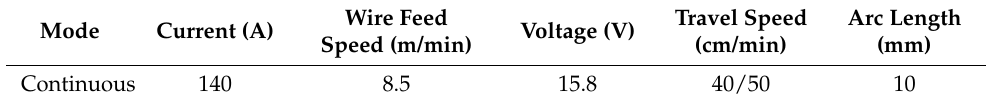
Figure 2. Set up for WAAM (wire and arc additive manufacturing) process: ( a ) CMT (cold metal transfer) torch attached to 6-axis robot, ( b ) chamber for protective atmosphere, ( c ) scheme of the torch. Table 1. CMT (cold metal transfer) welding parameters for parts manufacturing.